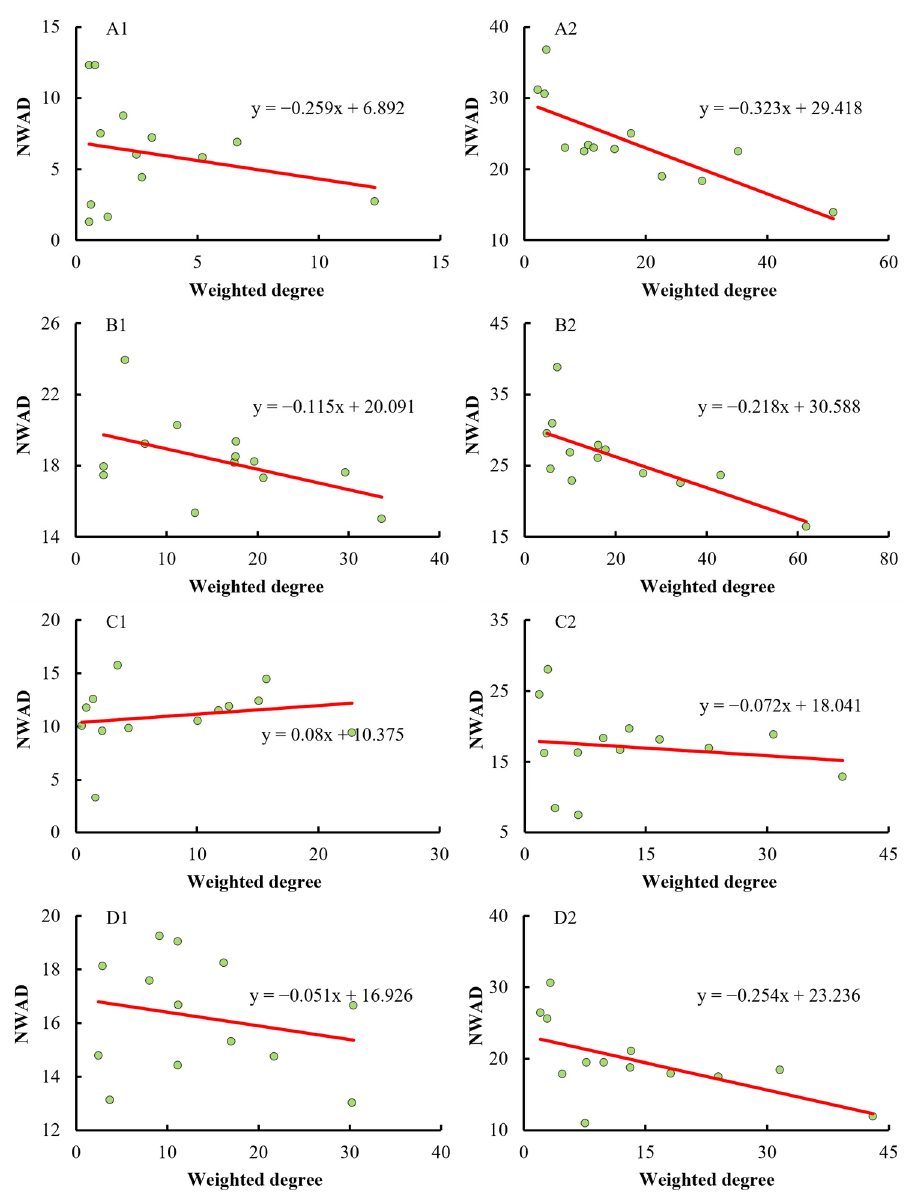
Figure 10. Changes in the weighted degree correlation of the population mobility networks in different periods.